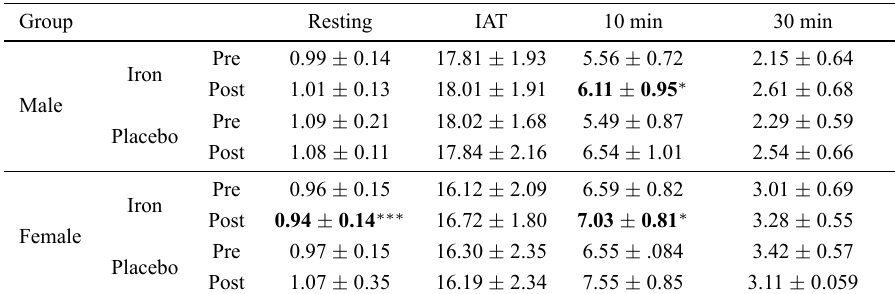
Table 4. Lactate levels in